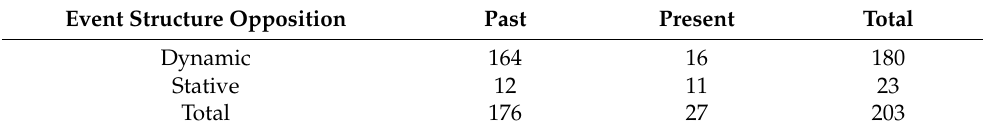
Table 9. Temporal anchoring of dynamic vs. stative utterances in all temporal contexts. Event Structure Opposition